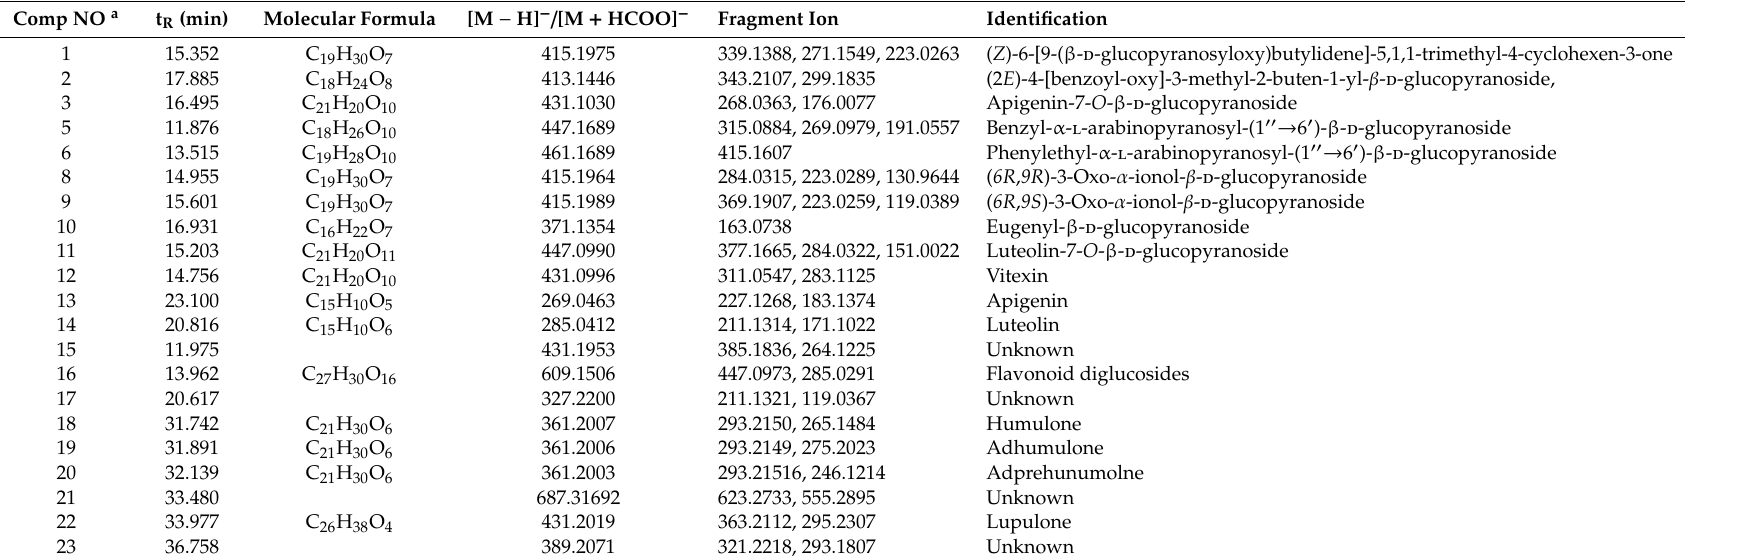
Table 2. Identification of isolated ( 1 – 14 ) and predicted ( 15 – 23 ) compounds from HJF by HPLC-qTOF-MS / MS analysis in negative ion